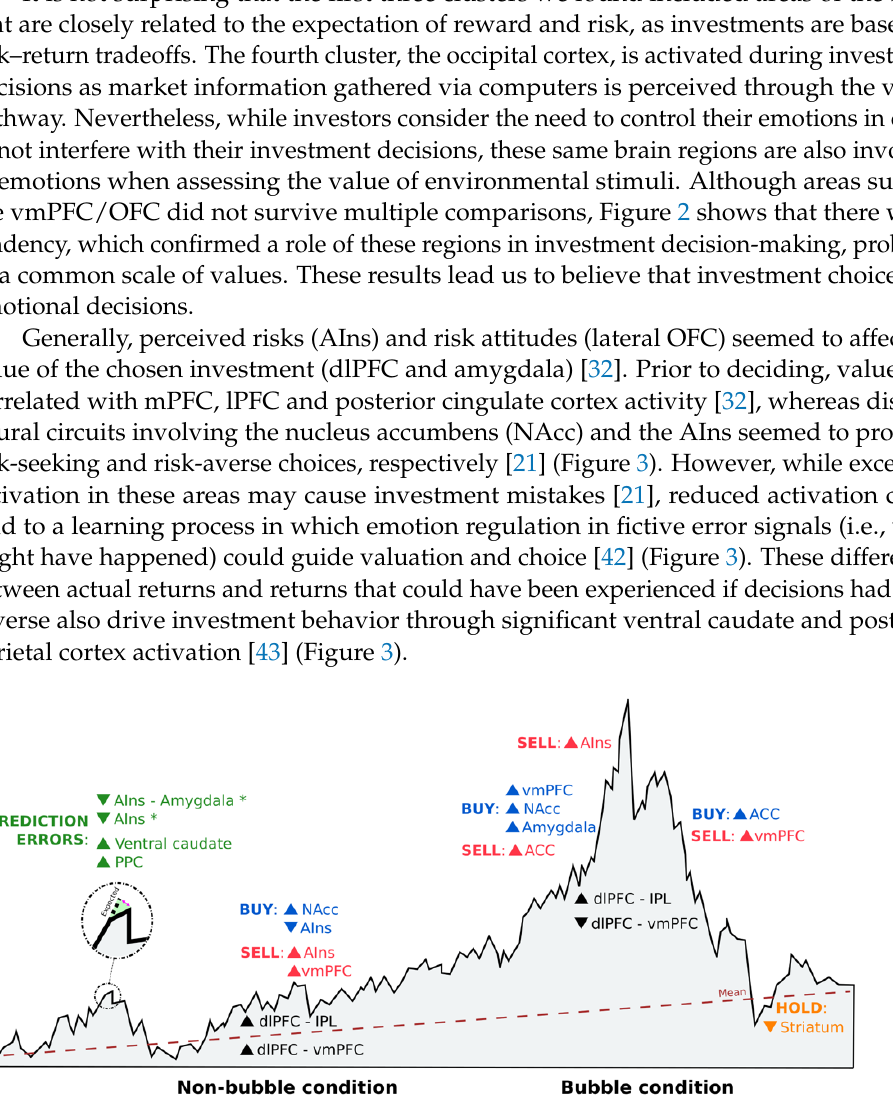
Figure 3. Schematic representation of brain activation reported in the ALE meta-analysis study during investment decision-making. Sell orders are shown in red, buy orders are in blue, and neither sell nor buy orders (hold) are in orange. Each order is accompanied by increased ( ▲ ) or decrease ( (cid:72) ) neural activity in certain brain areas. Prediction errors appear in green, where (*) indicates that reappraisal strategies were implemented. The location of each activation in the figure is based on the situation of the market, being under bubble or non-bubble conditions. Black indicates brain connectivity activation under both market conditions. AIns = anterior insula; PPC = posterior parietal cortex; NAcc = nucleus accumbens; vmPFC = ventromedial prefrontal cortex; ACC = anterior cingulate cortex; dlPFC = dorsolateral prefrontal cortex; and IPL = inferior parietal